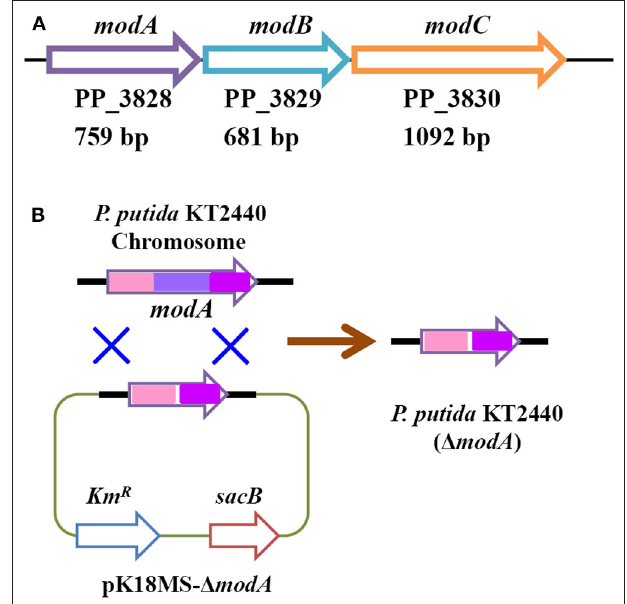
FIGURE 6 | Organization of molybdate transporter operon in P. putida KT2440 (A) and construction of modA -disrupted mutant strain (B) .